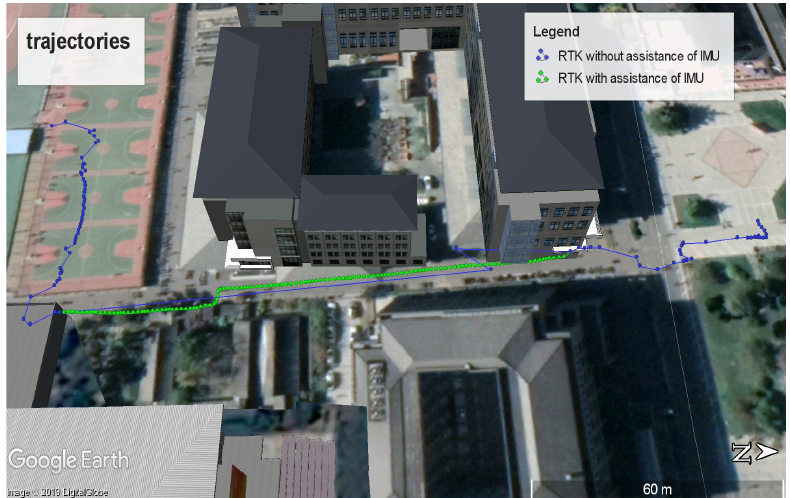
Figure 16. Trajectories in Google